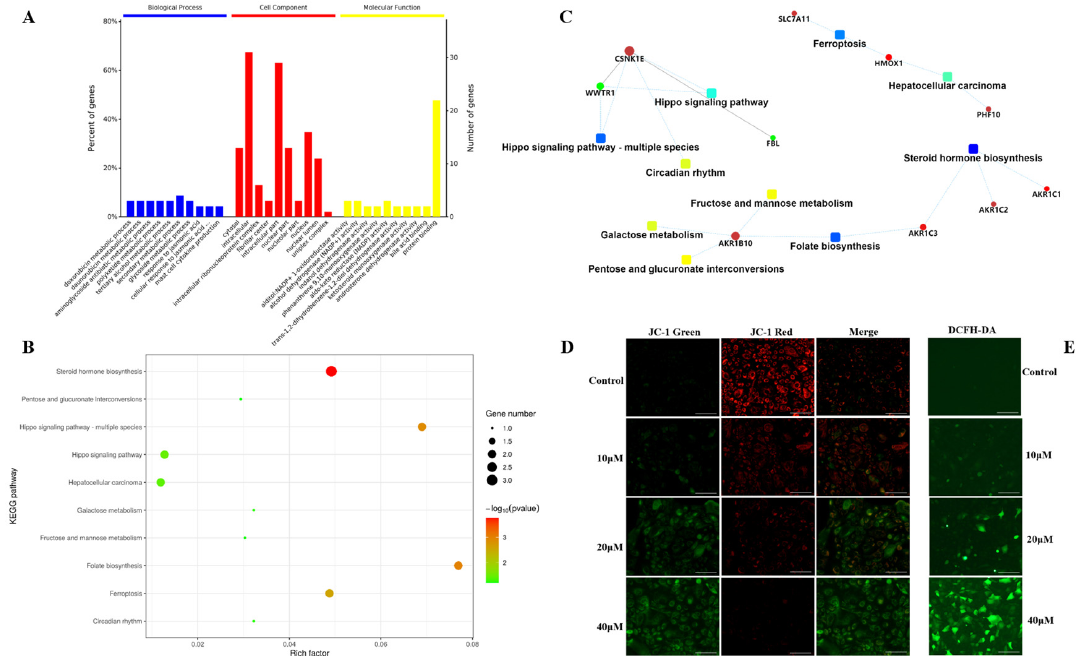
Figure 4. Functional enrichment and validation of carabrone regulatory proteins. ( A ) GO enrichment analysis. ( B ) KEGG enrichment analysis, shown as a pathway bubble chart of the top 10 results of differential proteins. ( C ) PPI network analysis. Circles refer to Protein/Gene and rectangles refer